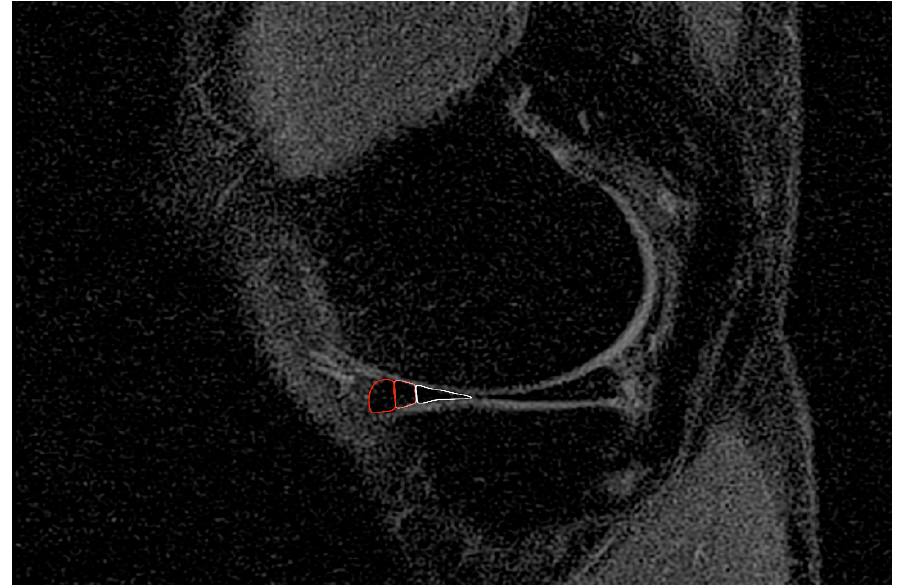
Figure 1. Red, red-white, and white zones of the